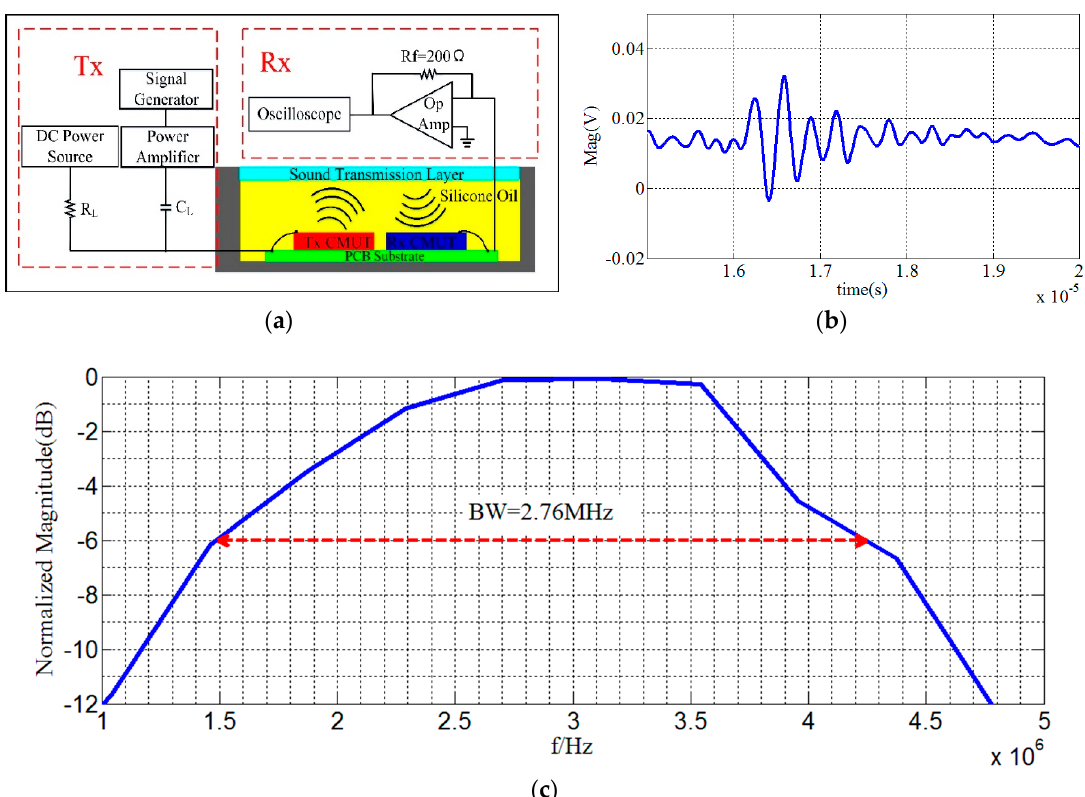
Figure 7. Transceiver testing of CMUT. ( a ) Schematic diagram of transceiver testing circuit; ( b ) echo signal of the CMUT; and ( c ) the normalized frequency response of the pulse-echo.